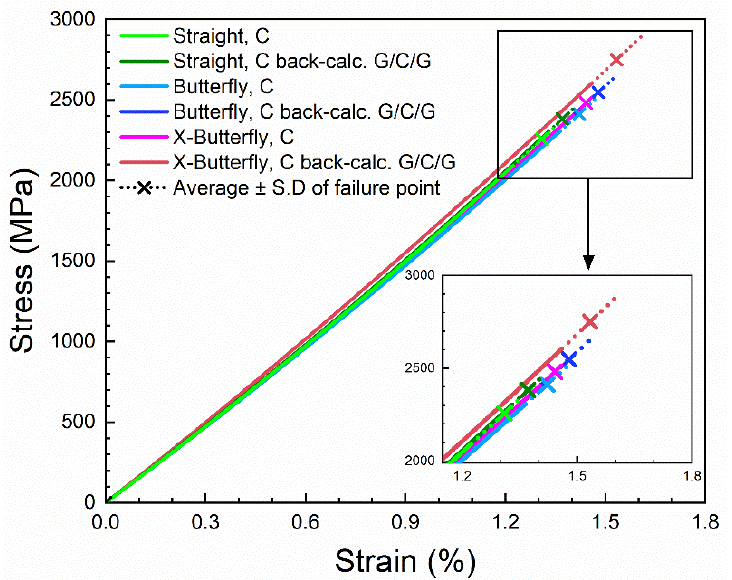
Figure 11. Back-calculated stress–strain curves of carbon composite layer from protected carbon composites, together with stress–strain curves of unprotected carbon composites.